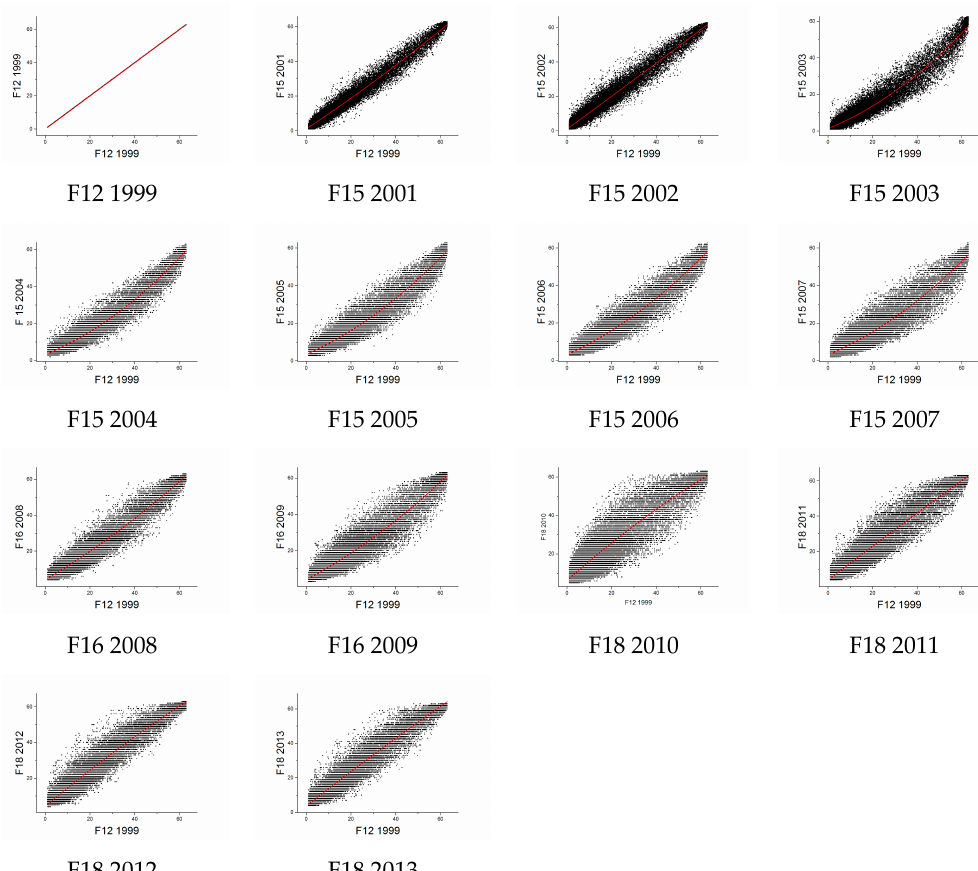
Figure 3. Scatter plot for image calibration for each year.